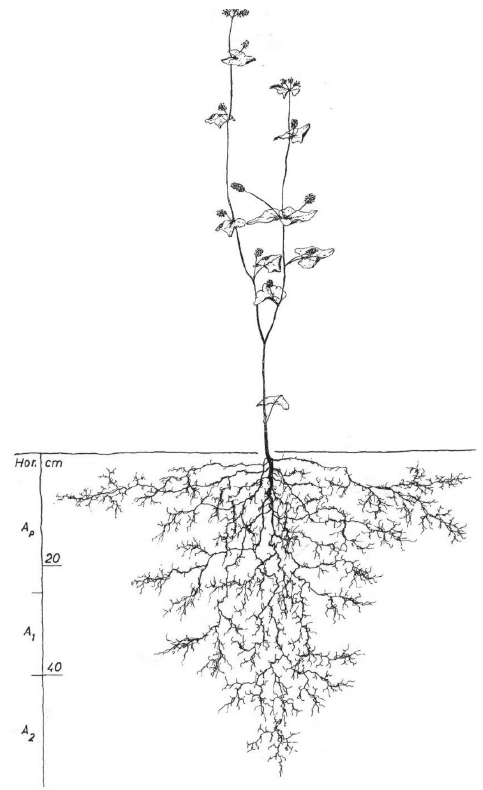
Figure 5. Example of field excavated, hand-drawn root system from the Root Atlas series. Fagopyrum esculentum ; height shoot : 82 cm, depth root : 58 cm, lateral extention root : 75 cm; location: St. Donat, Carinthia, 482 m NN., excavation: 23 June 2003. Soil type: colluvial Cambisol [29].